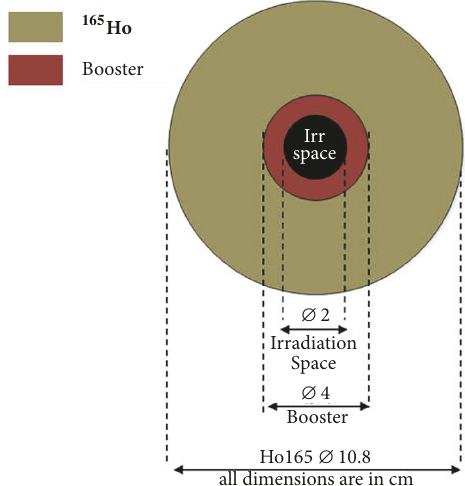
Figure 21: Irradiation device constituted by 165 Ho in combination with a booster (fissile material).